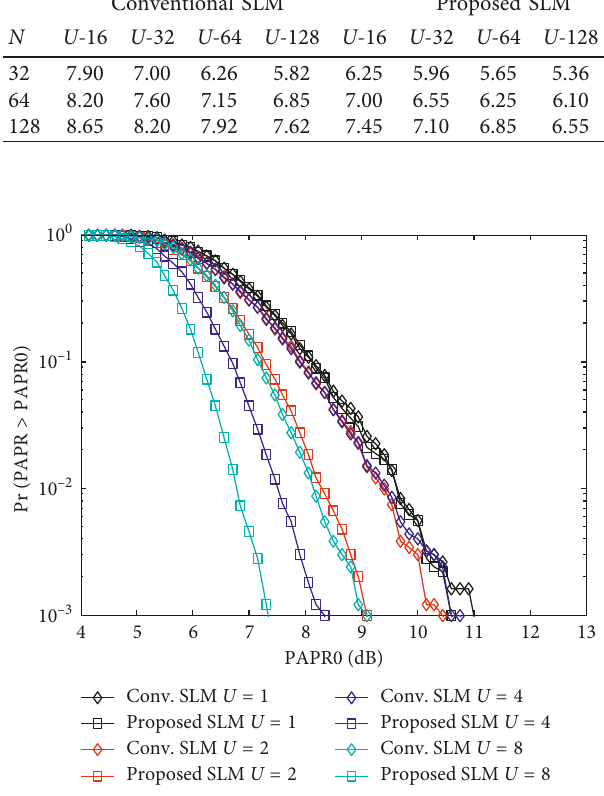
Figure 8: Comparison of SLM given in [5] with the proposed SLM for U � 1, 2, 4, and 8, N � 128, and